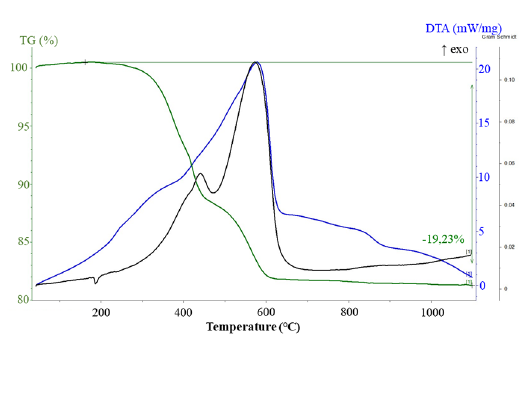
Figure 5. Thermogravimetric and differential thermal analysis of glass